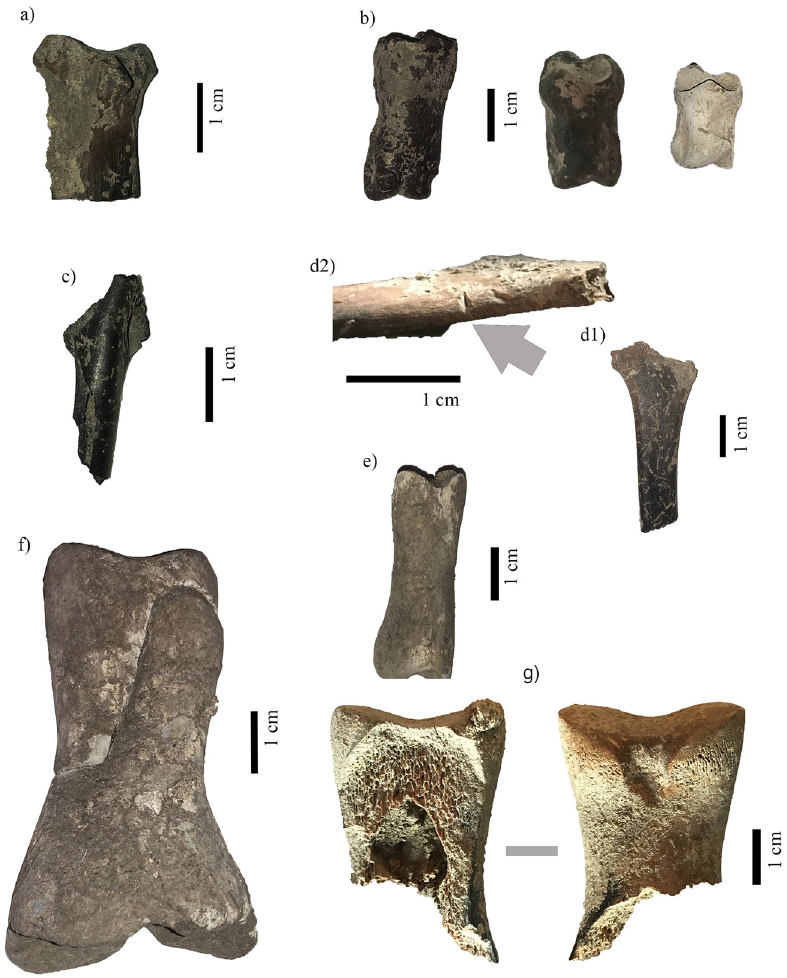
Figure 4: Selection of materials from pit 40: ( a ) Sus sp. metacarpal 3 proximal portion with burning in degrees 2 and 3; ( b ) Sus